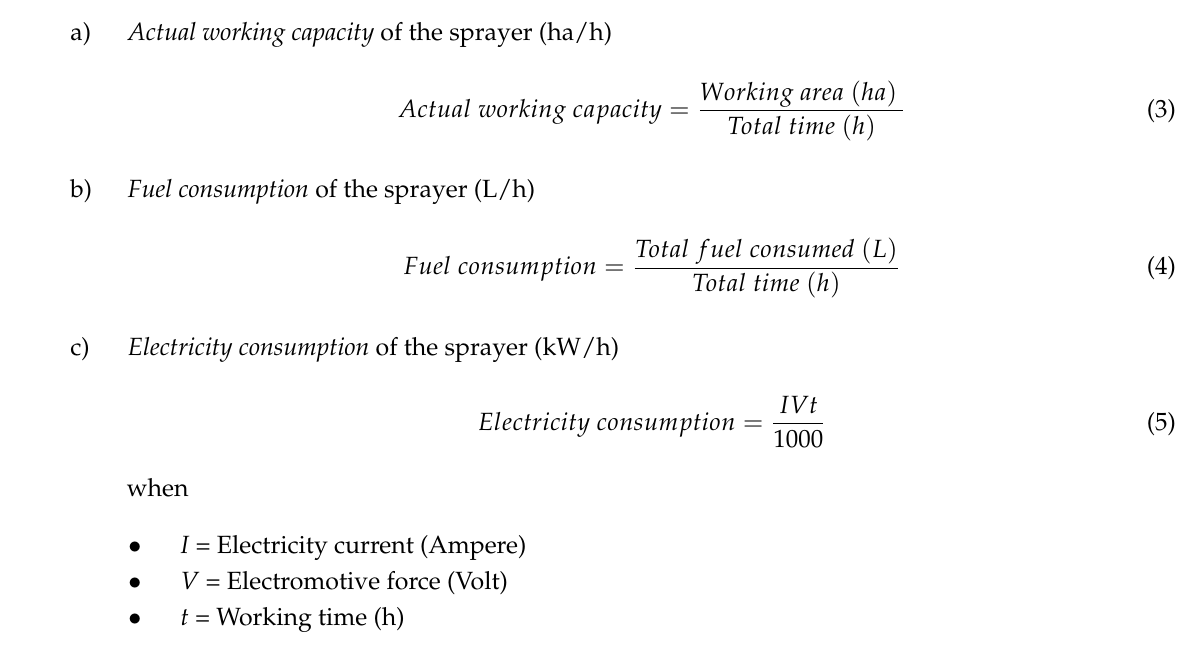
Figure 3. Image processing software; ( a ) Operating system; ( b ) Yellow thresholding.